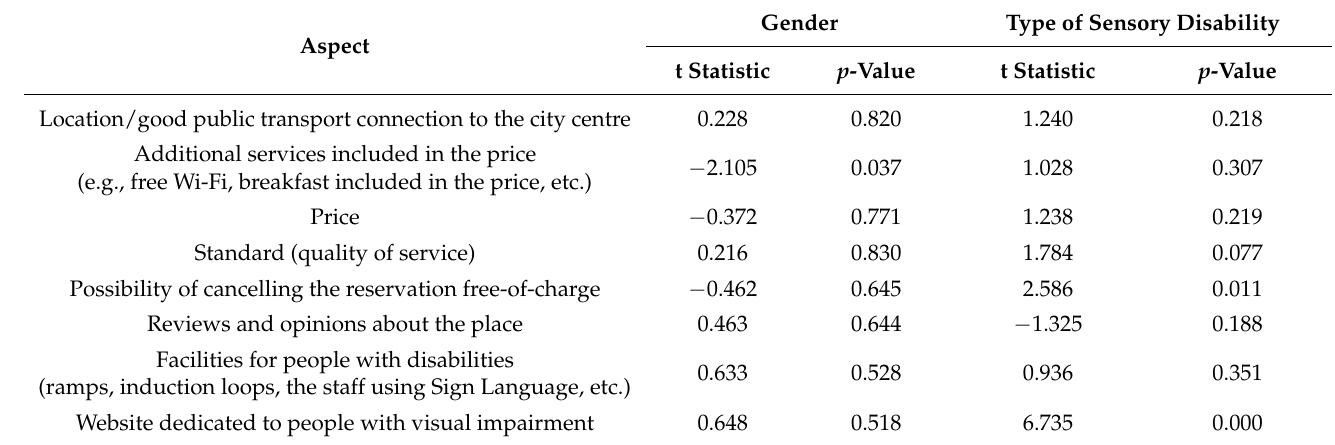
Table 11. Results of t-tests for aspects influencing the choice of accommodation with respect to gender and type of sensory